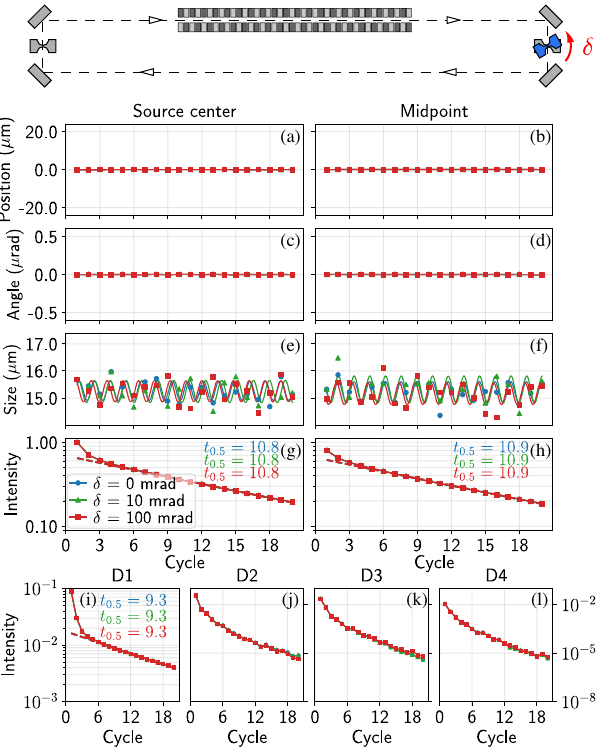
FIG. 18. Similar to Fig. 17, but with position error ξ at lens L 1 .